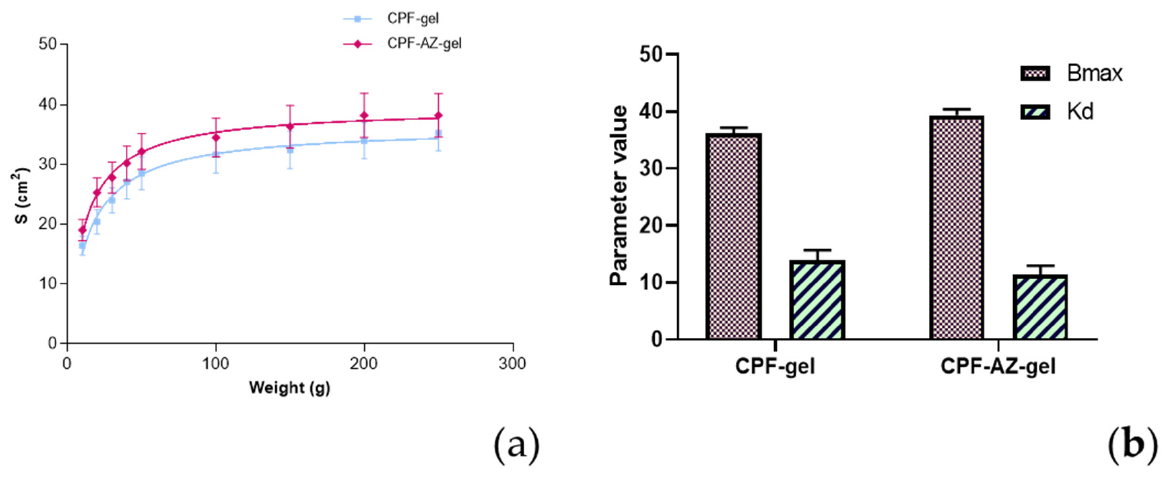
Figure 9. Evaluation of the spreadability of CPF-gel and CPF-AZ-gel, fitting a one-site hyperbola equation: ( a ) Spreading area (S, cm 2 ) as a function of the applied mass (g) at 22 ± 2 ◦ C; 60 ± 5% RH, and ( b ) plot of the parameters of the formulas of CPF-gel, and CPF-AZ-gel fitting a one-site hyperbola equation. The data are expressed as the mean ± standard deviation (SD) of the three replicates (n = 3). Table 4. Fi tt ing and goodness of fi t for the parameters estimated according to one-site hyperbola equations for the formulas CPF-gel and CPF-AZ-gel.